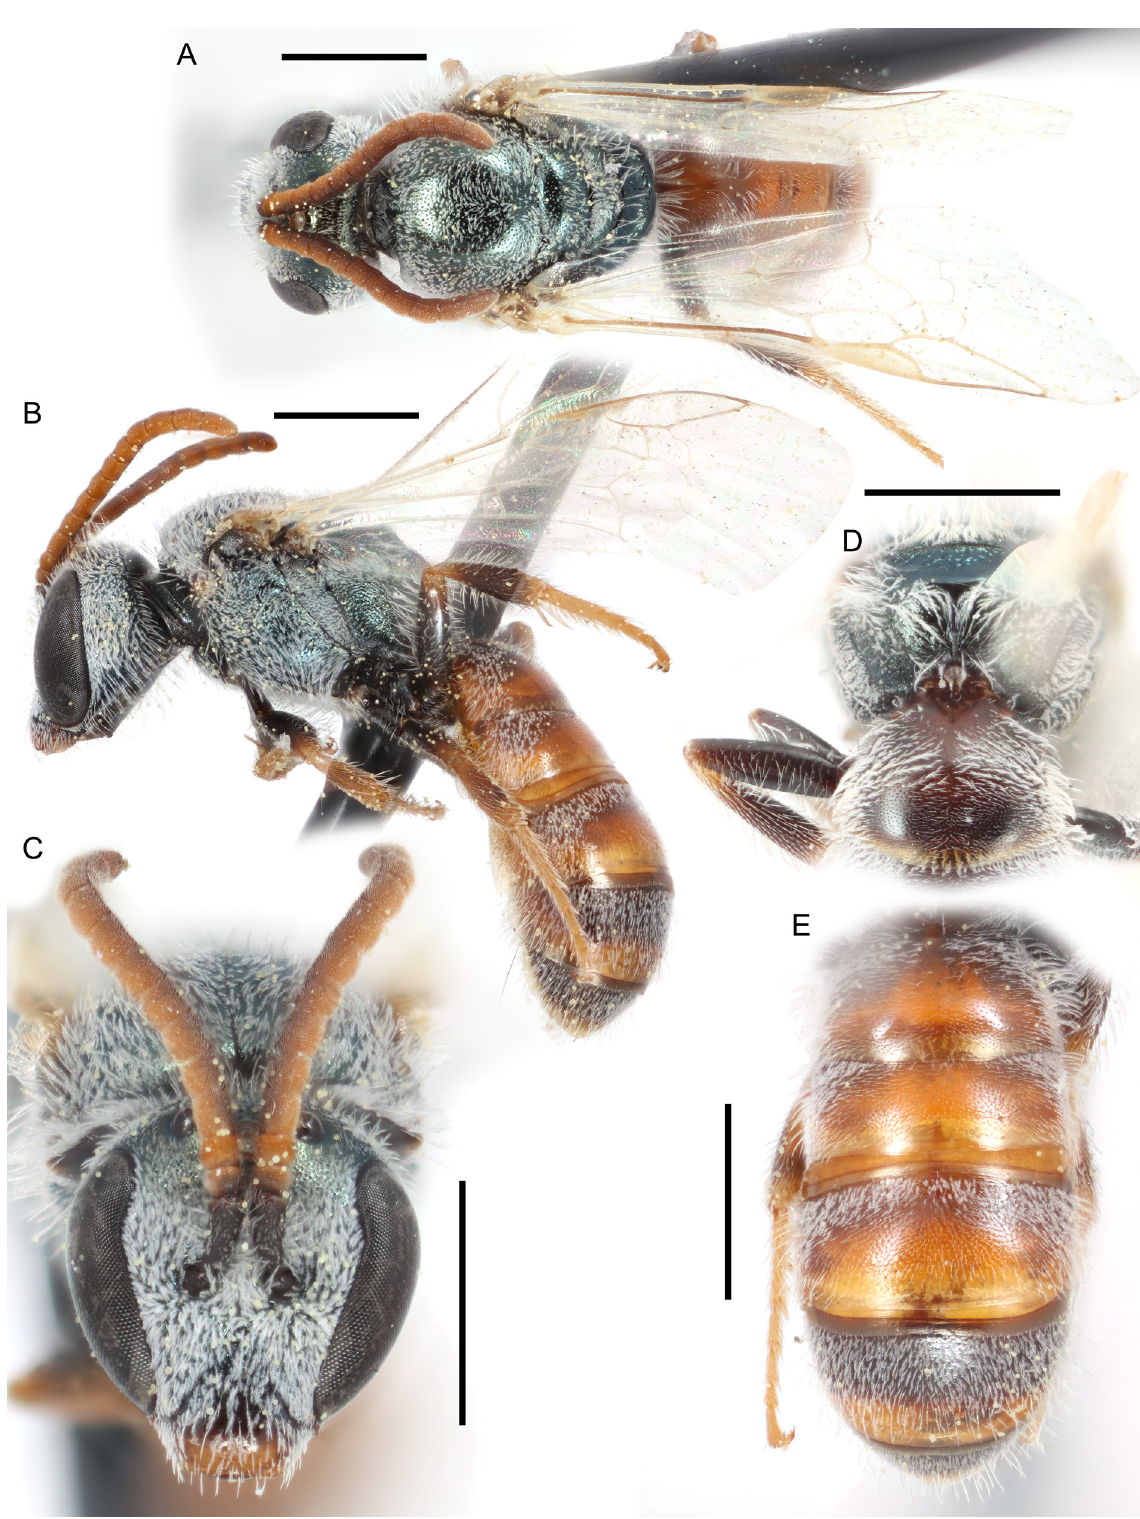
Fig. 53. Lasioglossum ( D. ) lilianae sp. nov., ♂. A . Dorsal habitus. B . Lateral habitus. C . Face. D . Propodeum. E . Metasoma. Scale bars: 1